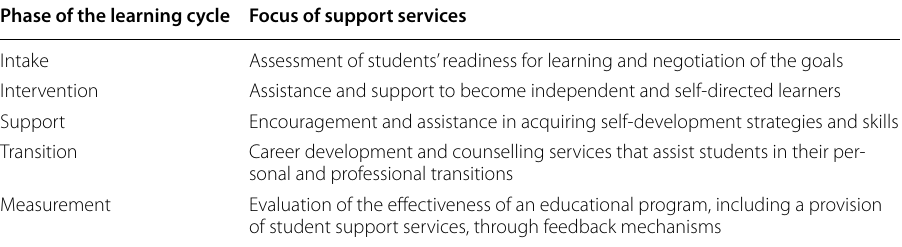
Table 1 Five phases of the learning cycle in the ISSPM model Phase of the learning cycle Focus of support services Intake Assessment of students’ readiness for learning and negotiation of the goals Intervention Assistance and support to become independent and self-directed